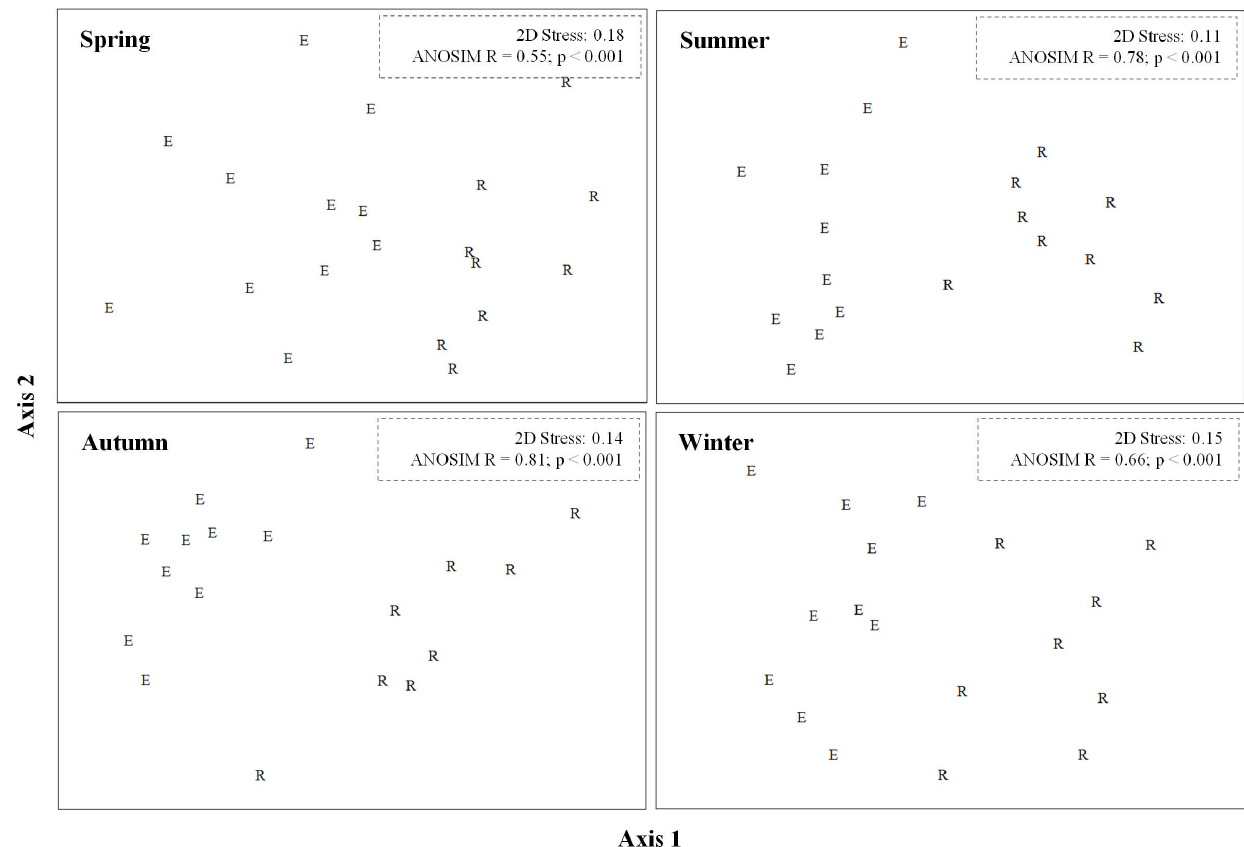
Figure 1. Non-metric Multidimensional Scaling ordinations of principal dietary items identified in the diet of elephant (E) and black rhinoceros (R) in the Addo Main Camp section. ANOSIM (Analysis of Similarity) R values indicate the degree of diet separation across seasons; values approaching unity indicate clear separation.